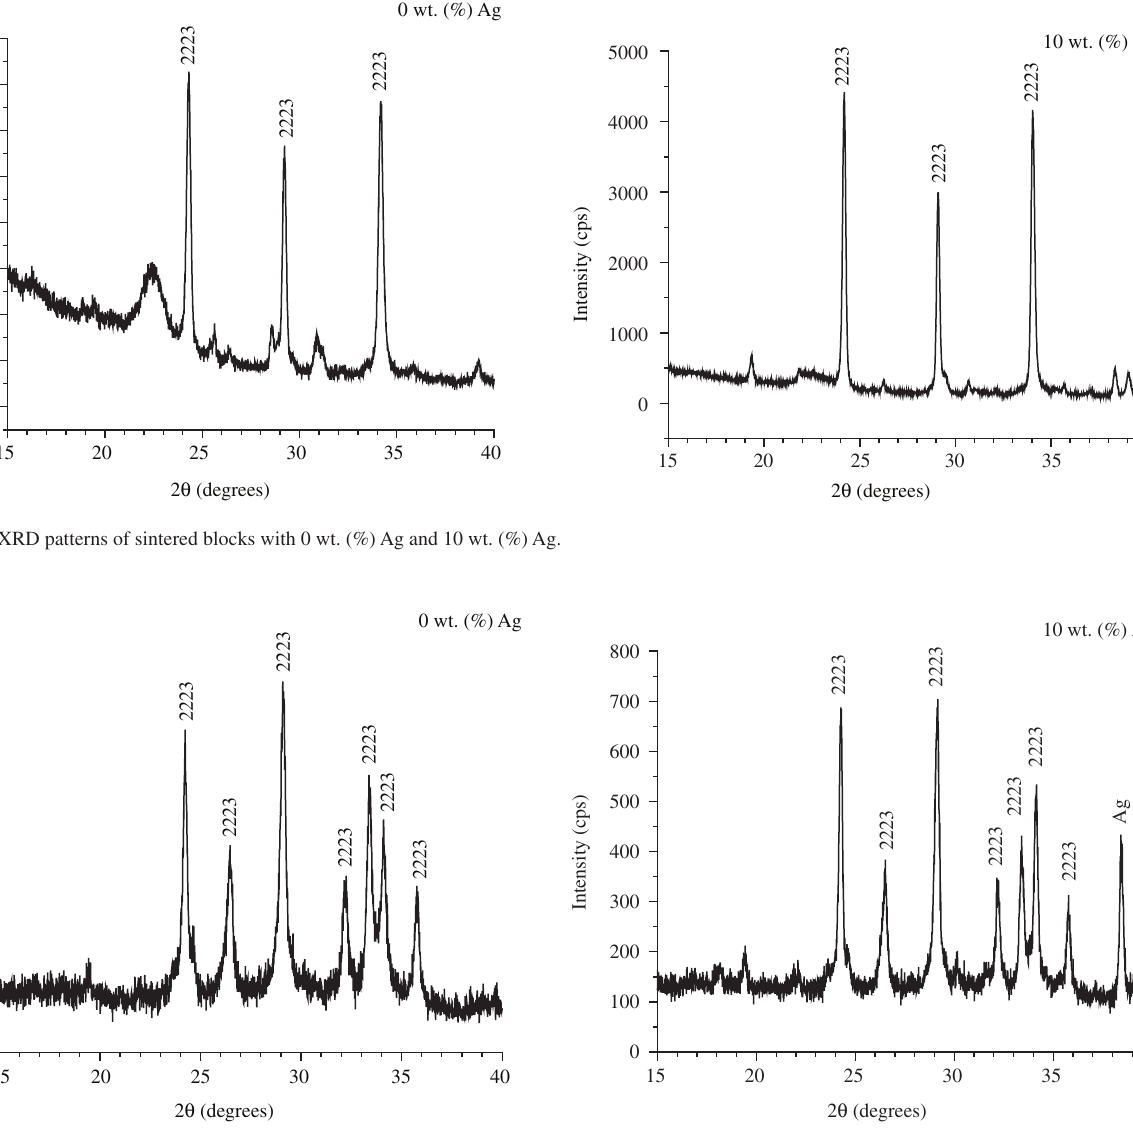
Figure 2. XRD patterns of powdered sintered samples with 0 wt. (%) Ag and 10 wt. (%)